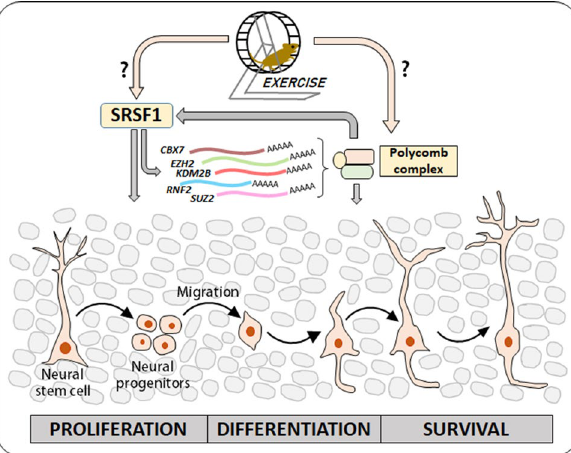
Fig. 4 A model of mutual-regulation of SRSF1 and polycomb gene transcripts influencing AHN. SRSF1 could be involved in post-transcrip- tional regulation of polycomb gene transcripts, and the polycomb complex could in turn regulate the transcription of SRSF1. These proteins could also influence multiple aspects of AHN. Further, SRSF1 and polycomb complex proteins could influence exercise-induced AHN by altering their target gene expression patterns. Hence, potential cross-talk between transcriptional and post-transcriptional regulators may influence